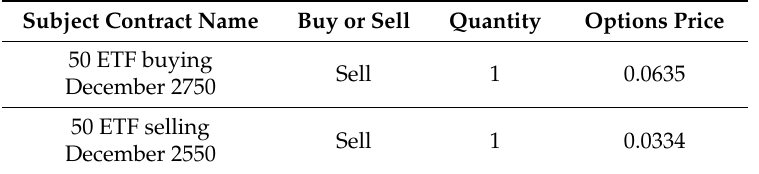
Table 1. Example of a strangle options short-sell investment